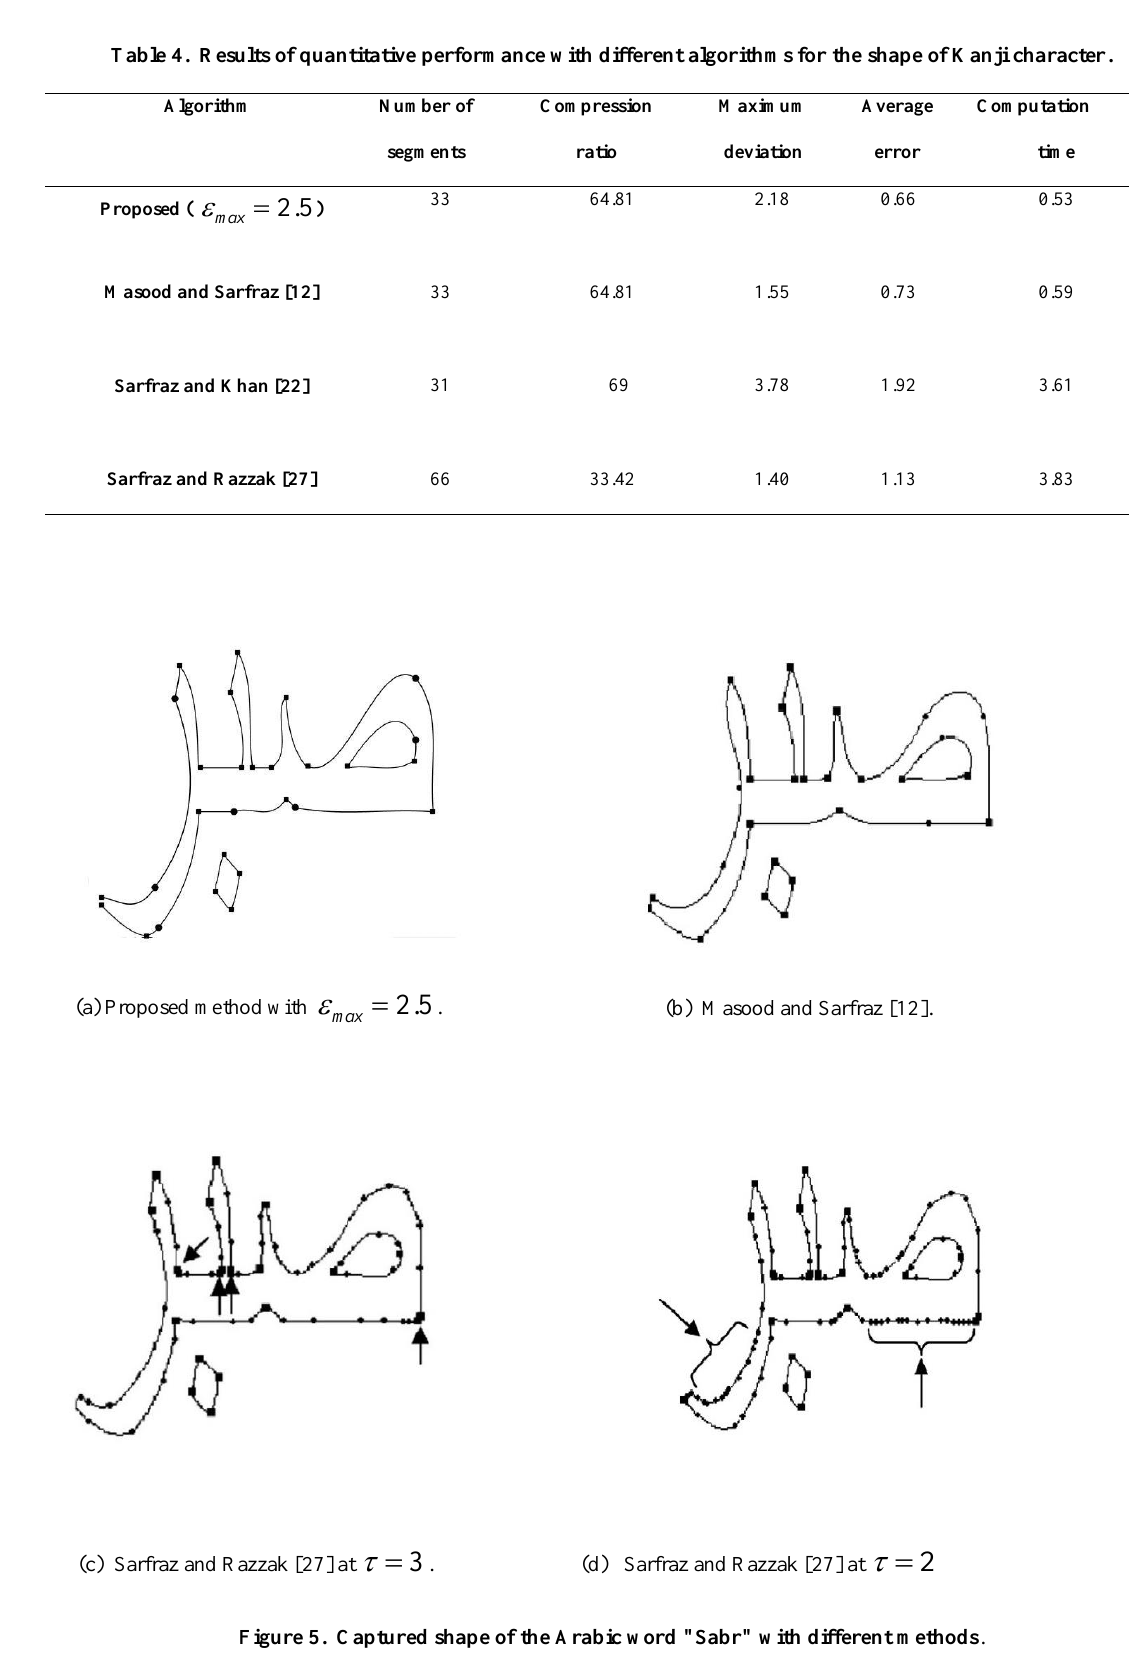
Figure 5. Captured shape of the Arabic word "Sabr" with different methods